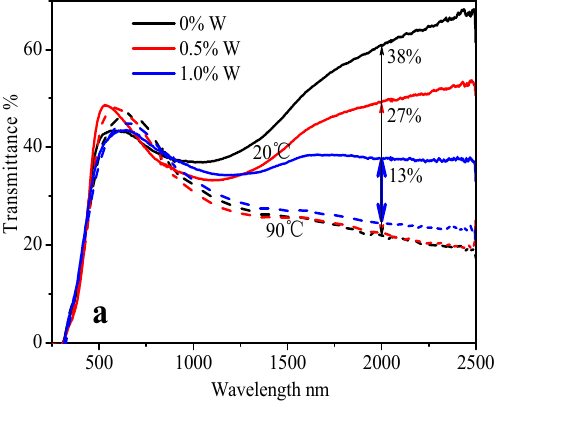
Figure 6. Transmittance curves ( a ) and thermal hysteresis loops ( b ) of VO 2 films with different W doping concentrations prepared by professional annealing of 45 nm W:V films at 450 Pa, 400 °C for 1 h; solid line: 20 °C, dashed line: 90 °C in ( a ).